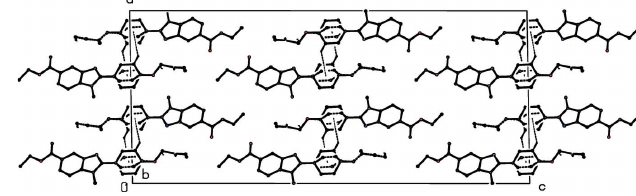
Figure 9 A projection along [010] of part of the crystal structure of compound (I) showing the arrangement of the punctuated ribbons within the unit cell. Hydrogen bonds are drawn as dashed lines and, for the sake of clarity, the H atoms not involved in the motifs shown have been omitted.